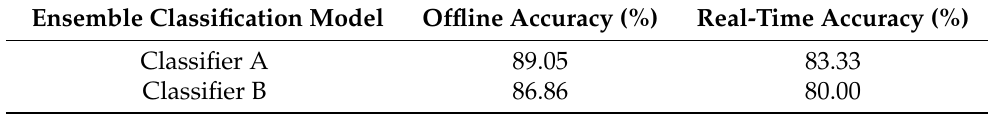
Table 3. Offline and real-time classification accuracy using ensemble of